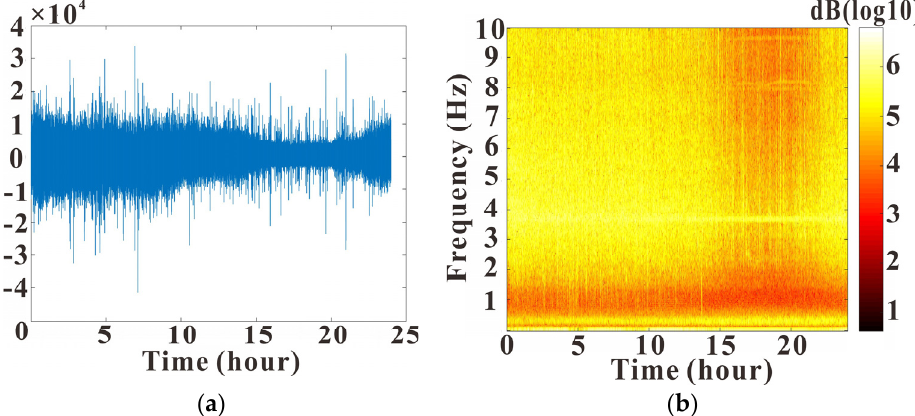
Figure 3. ( a ) One-day ambient-noise waveform from station WL.B04 on 2 August 2018. ( b ) Spec- trograms of the vertical component data by short-time Fourier transform. The amplitude spectrum decreases sharply from 15:00 to 22:00 UTC time (23:00 to 06:00 China Standard Time). The difference is caused by periodic low anthropogenic activities in Hangzhou during the